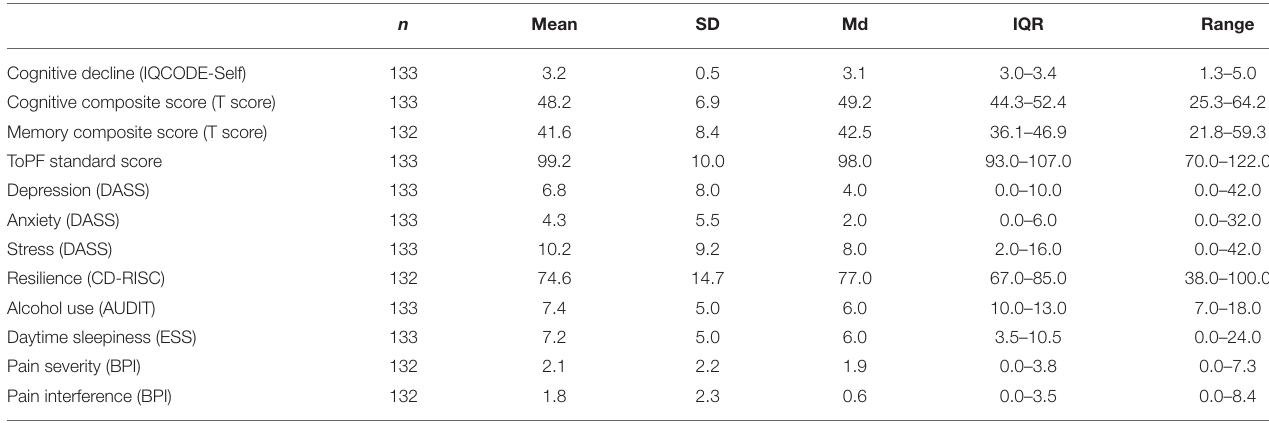
TABLE 2 | Self-report and cognitive